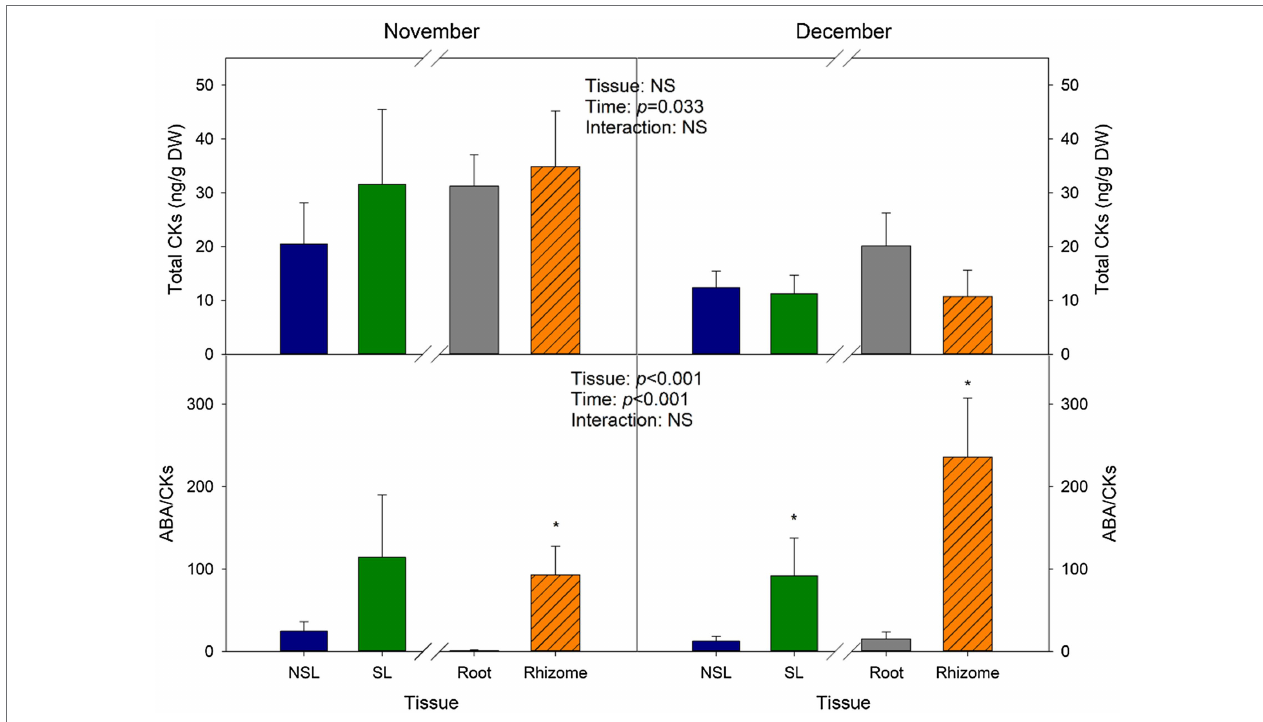
FIGURE 4 | Cytokinin variations with time and between leaf type and belowground organ type. Total cytokinin levels (Total CKs) and ABA/CKs ratio in leaves (SL, NSL) and subterranean organs (roots and rhizomes) from I. pseudacorus individuals growing in natural conditions. Values of p from the two-way mixed factorial analysis are shown, including the factor Time , Leaf type/Tissue , and their interaction. An asterisk indicates differences between leaf types or root tissue types. Data show the mean ± SE of n = 12 individuals. NSL, non-senescent leaf; SL, senescent